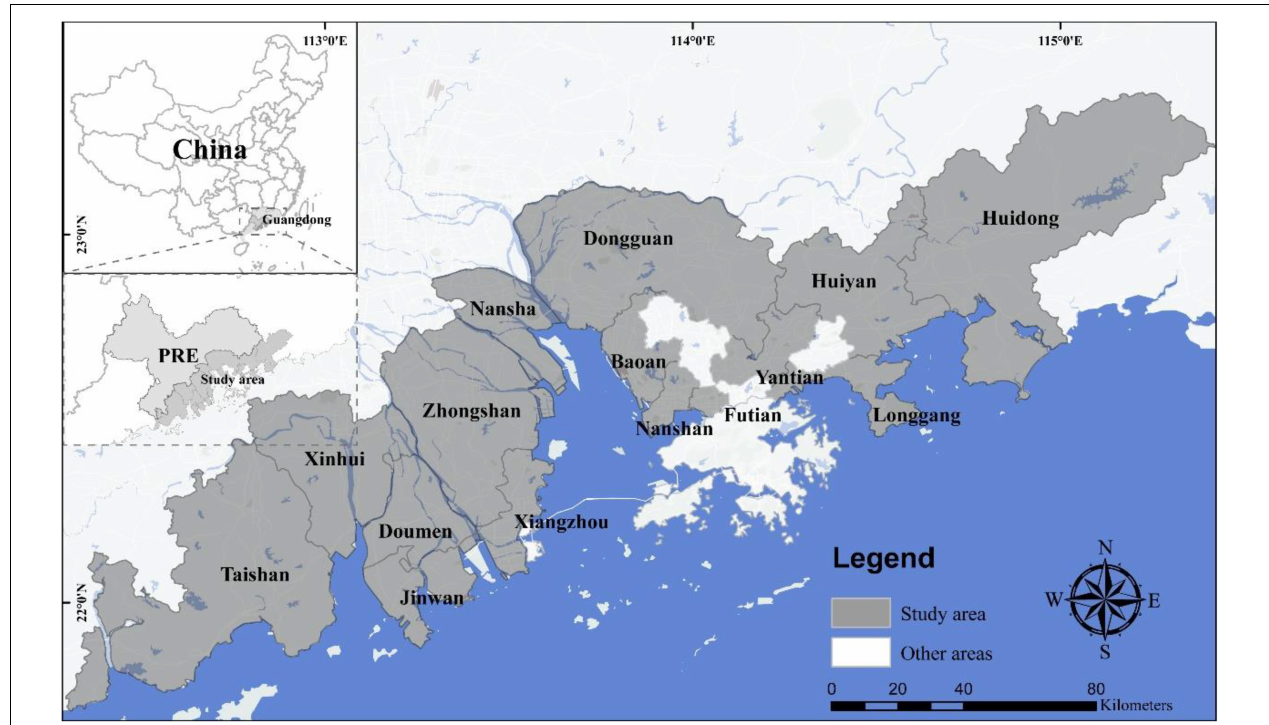
FIGURE 1 | ThePRE is located in the southeast coast of Guangdong Province, China. The study area encompasses 15 counties and districts along the PRE coast (study areas are gray, and other areas are white).